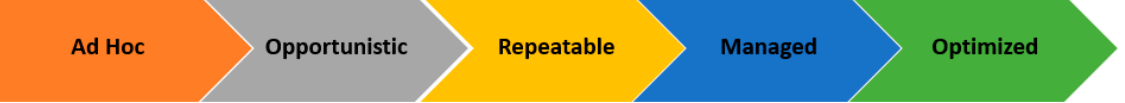
Figure 9. Big Data Business Model Maturity Index.